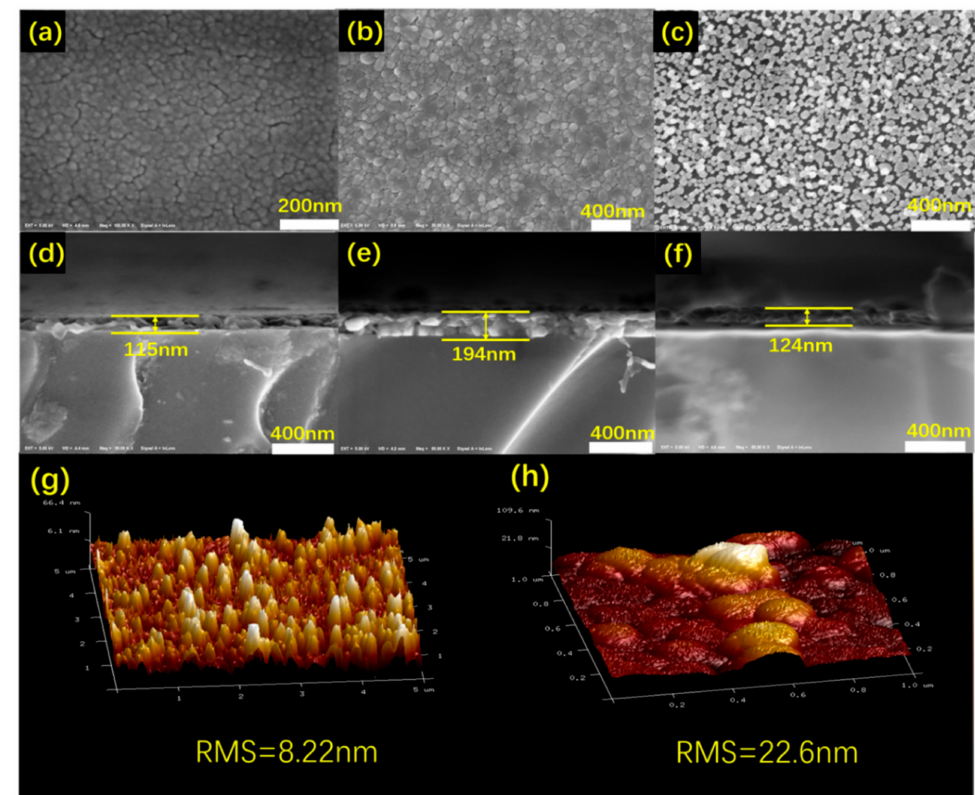
Figure 3. Top view SEM images of surface morphology of ( a ) pure VO 2 film, ( b ) sample S1 and ( c ) sample S2, cross-section SEM images of ( d ) pure VO 2 film, ( e ) sample S1 and ( f ) sample S2 and AFM images of ( g ) sample S1 and ( h ) sample